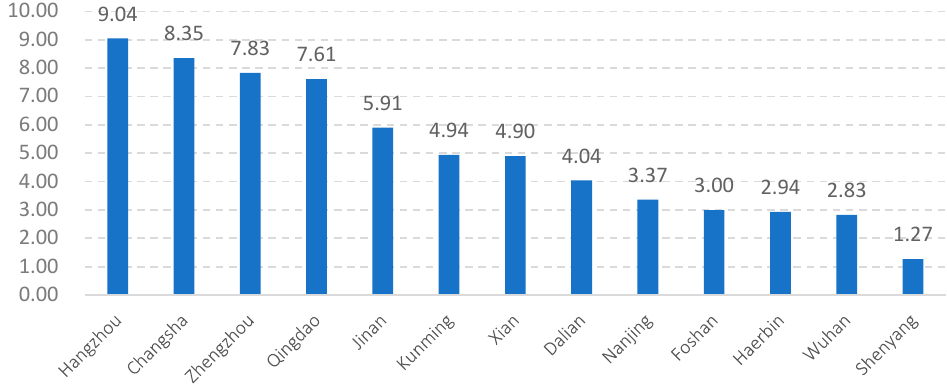
Figure 1. Growth rate of population of Chinese megacities from 1982 to 2020 (megacities are cities with a population of 5 million to 10 million).